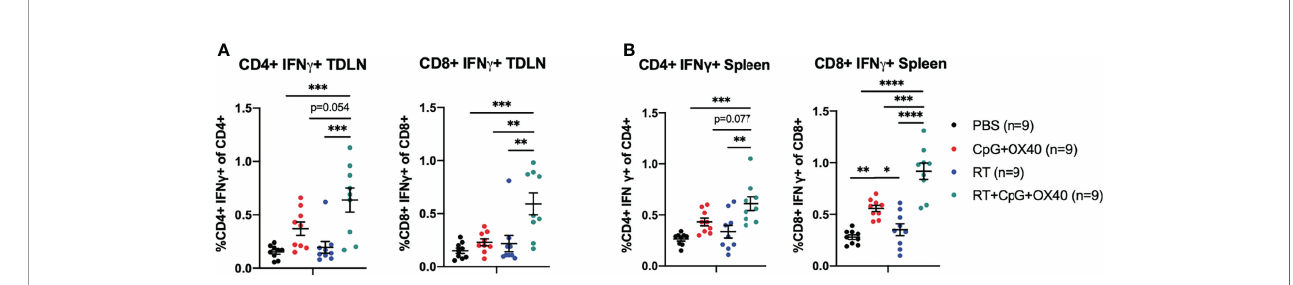
FIGURE 6 | RT+CpG+OX40 Increases CD4+ and CD8+ T Cell Activation in the TDLN and Spleen. The combined results from two independent experiments (n=4-5 per group, per experiment) showing the percent of CD4+ and CD8+ T cells that were positive for IFN g , without ex vivo stimulation, in the TDLNs (A) and spleens (B) of mice treated with PBS (black), CpG+OX40 (red), RT (blue), and RT+CpG+OX40 (teal). Each symbol represents the immune cell double positive percent from one mouse. Flow gating strategy for these analyses is presented in Supplementary Figure 5 . P values were calculated using one-way ANOVA with Tukey ’ s